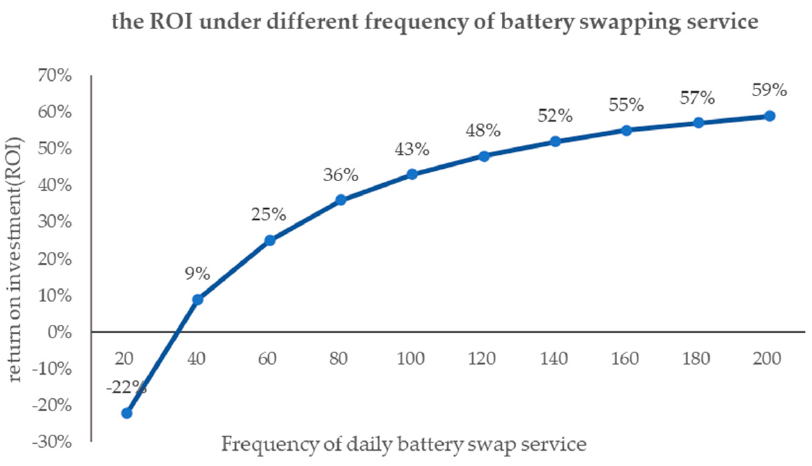
Figure 9. The ROI based different frequencies of battery swapping.